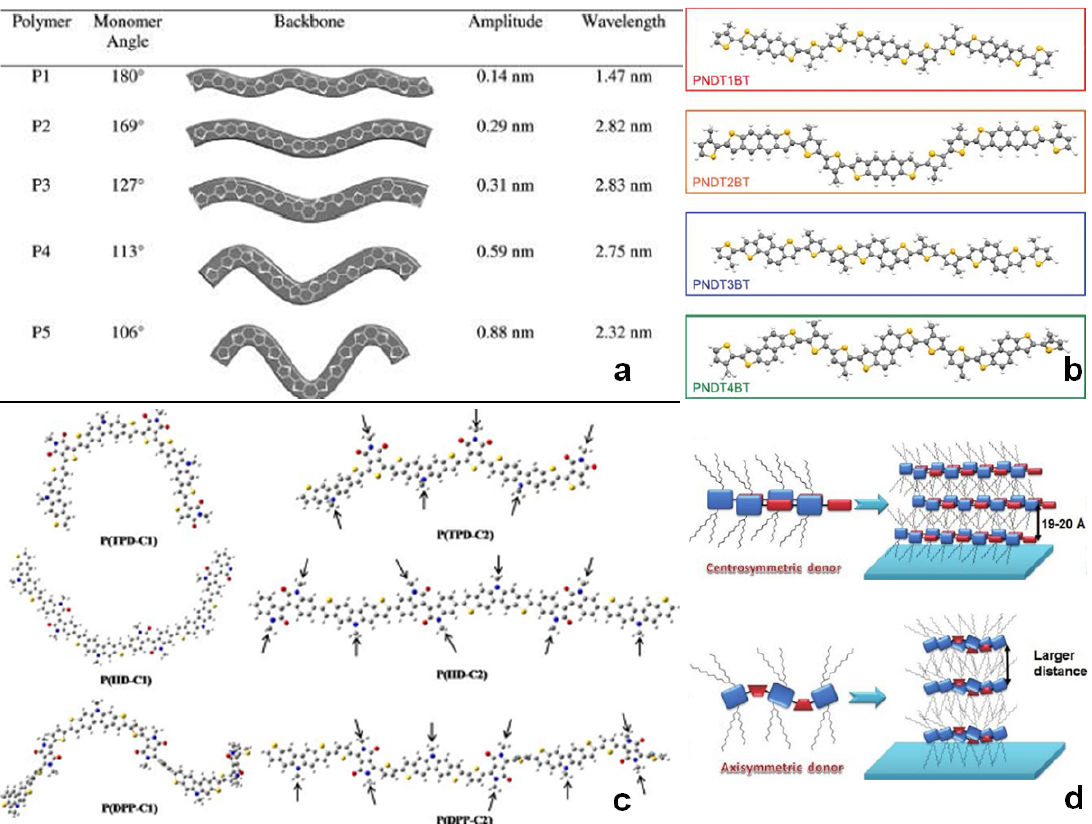
Figure 12. ( a ) Geometry of the polymers: the monomer angle refers to the angle which is introduced by the corresponding benzodithiophene into a linear polymer chain (Reprinted with permission from [122]. Copyright 2010 American Chemical Society); ( b ) Optimized backbone structures of the polymers based on isomers of naphthodithiophene (Reprinted with permission from [112]. Copyright 2011 American Chemical Society); ( c ) Optimized backbone conformation of the polymers base on isomers of dithienocarbazole (Reprinted with permission from [111]. Copyright 2012 American Chemical Society); and ( d ) The cartoon representation of copolymers with different symmetries and their film packing (Adapted with permission from [86]. Copyright 2012 American Chemical